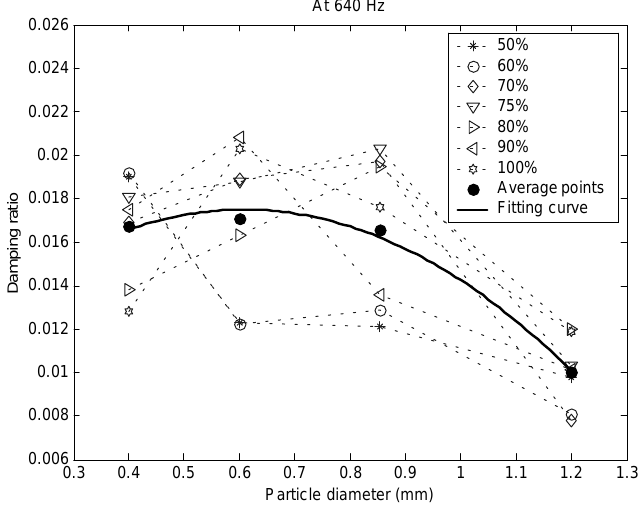
Fig. 11. Damping ratio vs. particle diameter for different packing ratios at 640